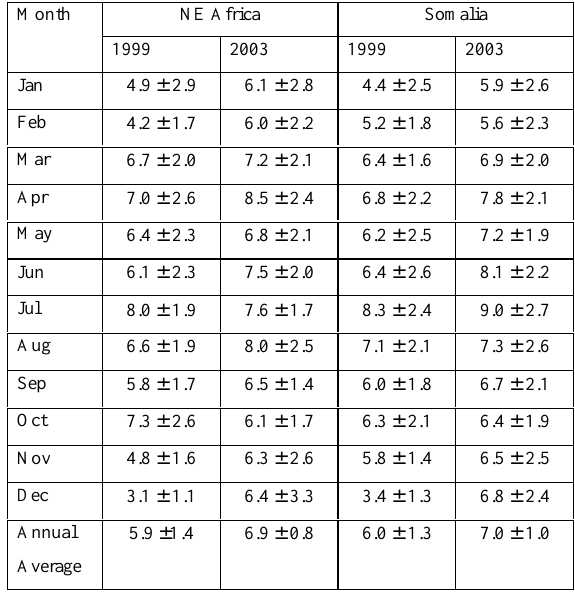
Table 4. Comparison of monthly mean IDDI (K). Table-4 . Comparison of Monthly Mean IDDI